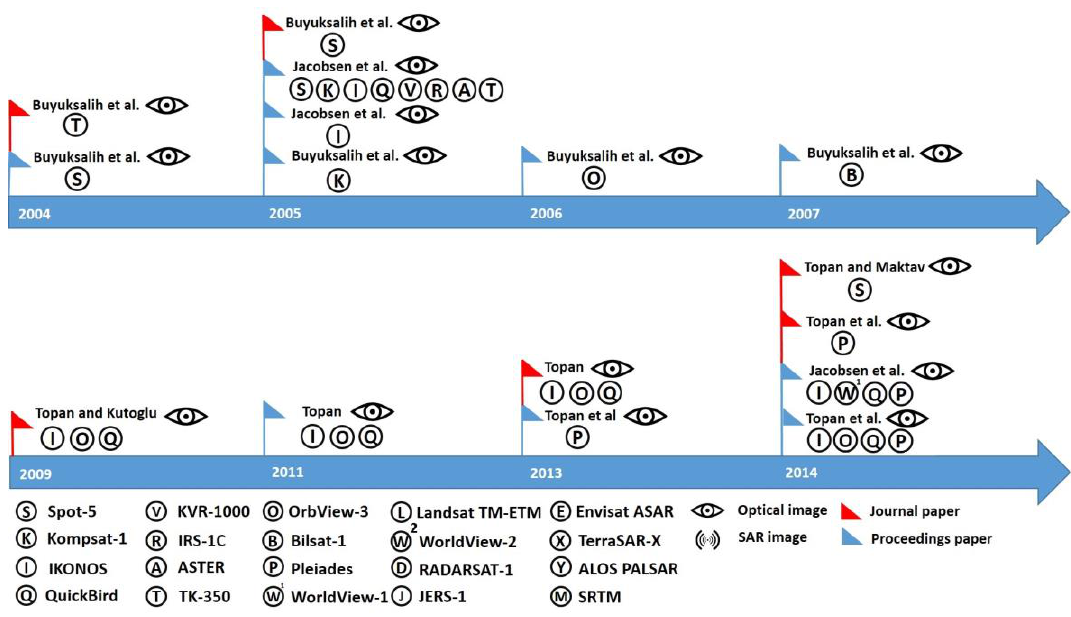
Figure 3. Summary of previous studies of 2/3D georeferencing accuracy